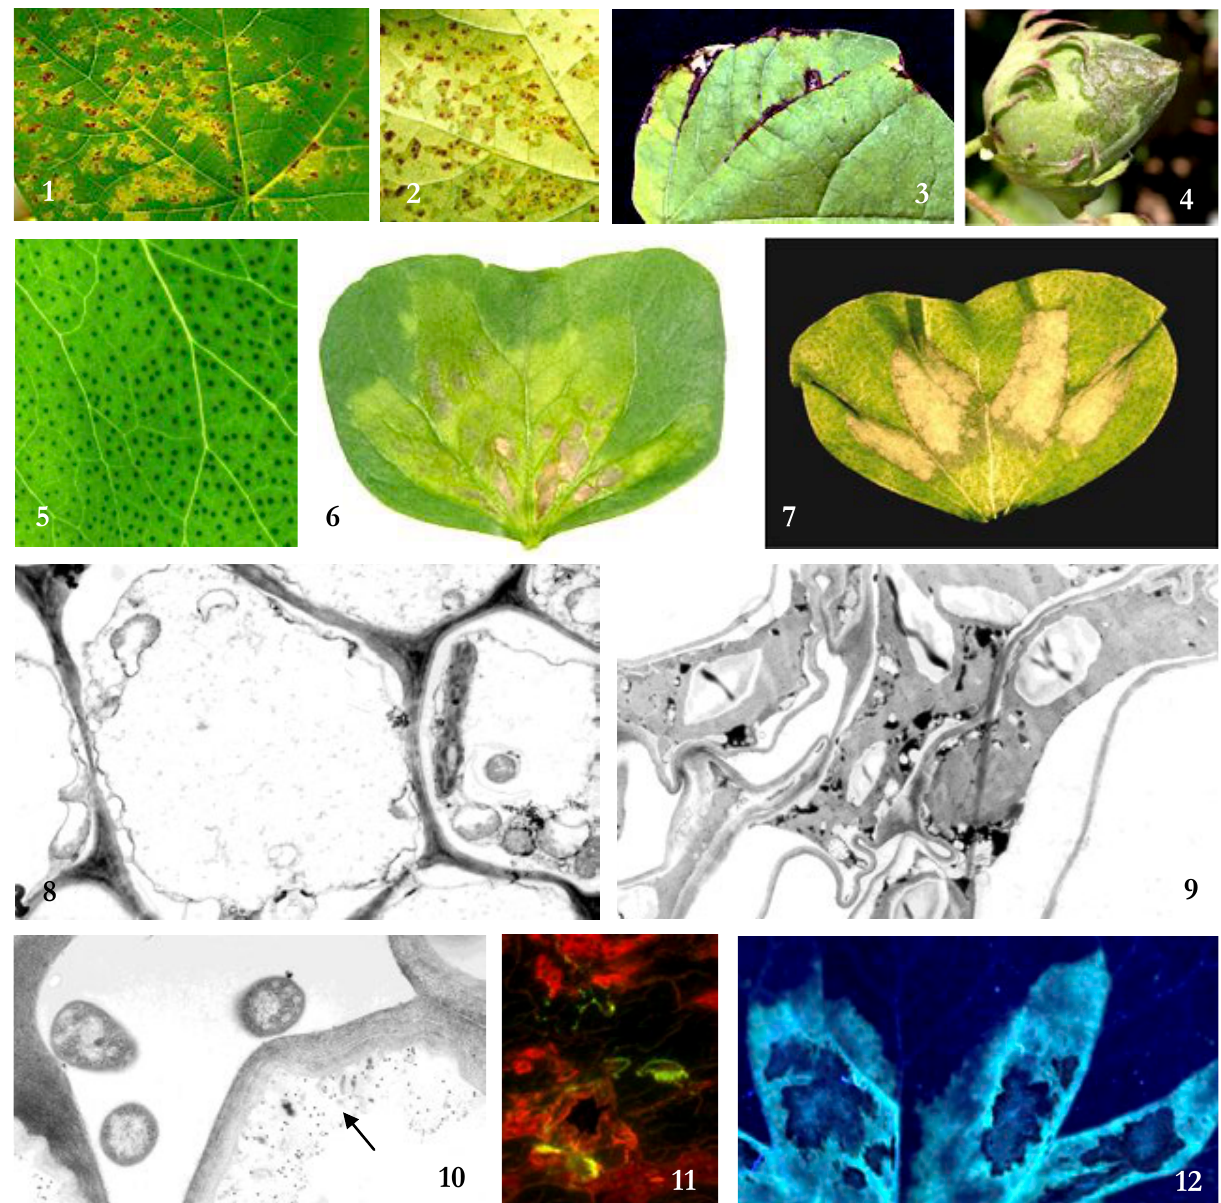
Figure 1. Symptoms of cotton bacterial blight on leaves showing angular leaf spots (1), water-soaked lesions (2), stem black arm lesions (3), fruit necrosis and gummosis (4). Susceptible cotyledons artificially infected displayed chlorosis and necro - sis (6) as compared to healthy tissues in non-infected cotyledons (5). Xanthomonas citri pv. malvacearum -infiltrated areas of resistant cotyledon showed dry lesions typical of the HR cell death symptoms (7). Electron microscopic images of infected tissues in susceptible (8) and resistant leaves (9) 16 hours post-inoculation showing cell degradation and coagulation of the cytoplasm, respectively, bacterial cells in intercellular localization (10) close to a papilla immunolabelled for callose detec- tion (arrow). Light microscope images showing yellow-green fluorescence of callose deposits stained with aniline blue in infected resistant leaves (11) and HR areas with blue bright fluorescence under UV illumination, indicating the presence of phenolic-like compounds (12). Photo credits. 1, 2 and 7, A. Jalloul; 3, J.F. Daniel; 4, 8, 9, 10, 11 and 12, M. Nicole; 5 and 6, M.